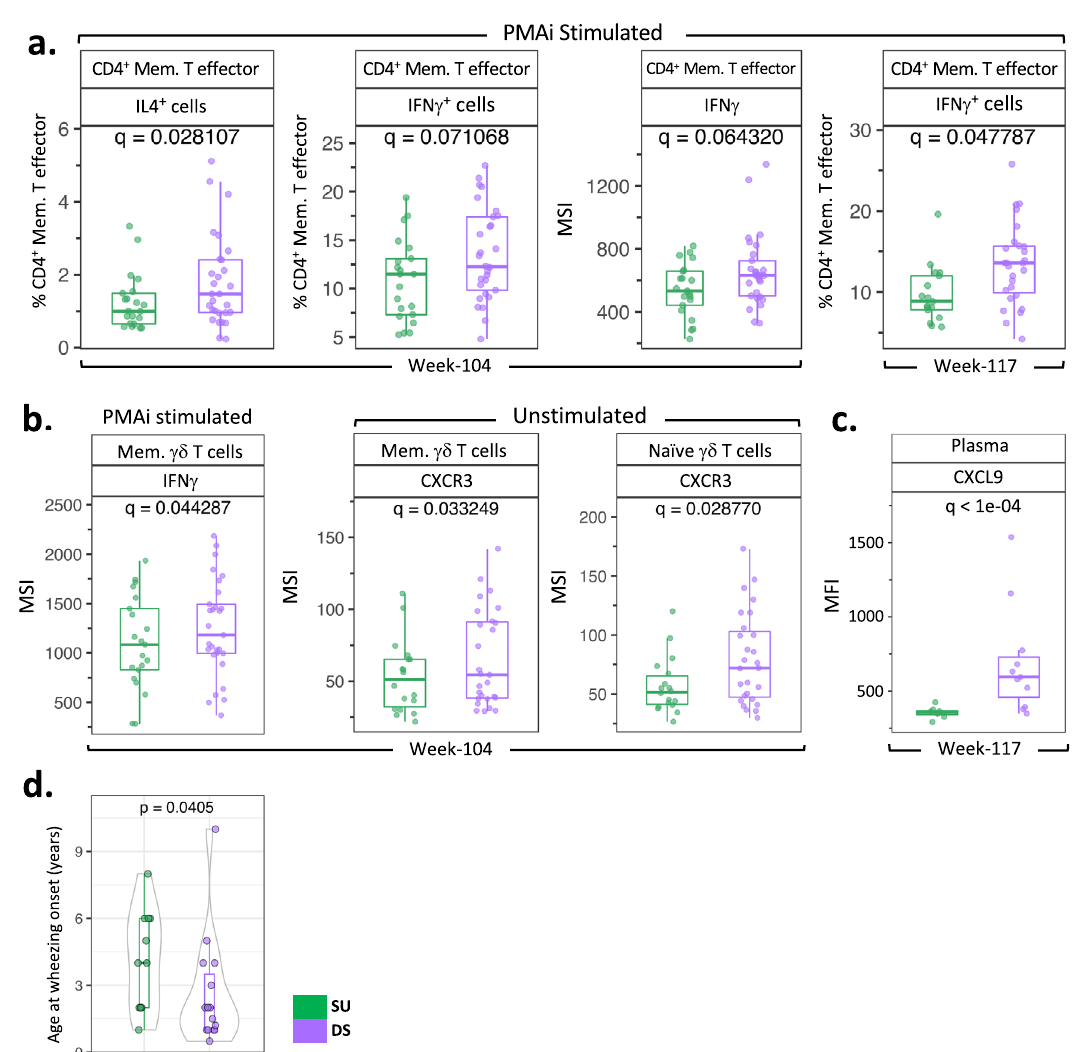
Fig. 4 | Higher frequency and expression of IFN γ as an additional distinctive featureofDSvs.SUparticipants.a FrequencyofIL-4 + CD4 + memoryTeffectorsat week104,frequenciesofIFN γ + CD4 + memoryTeffectorsatweek104andweek117, andexpressionofIFN γ inCD4 + memoryTeffectorsatweek104inPMAi-stimulated PBMCsfromSUvs.DS[week104(PMAistim:SU, n =21,DS, n =29);week117(PMAi stim:SU, n =17,DS, n =27)]. b ExpressionofIFN γ inmemory γδ TcellsamongPMAi- stimulated week 104 PBMCs from SU vs. DS; expression of CXCR3 in memory and naive γδ